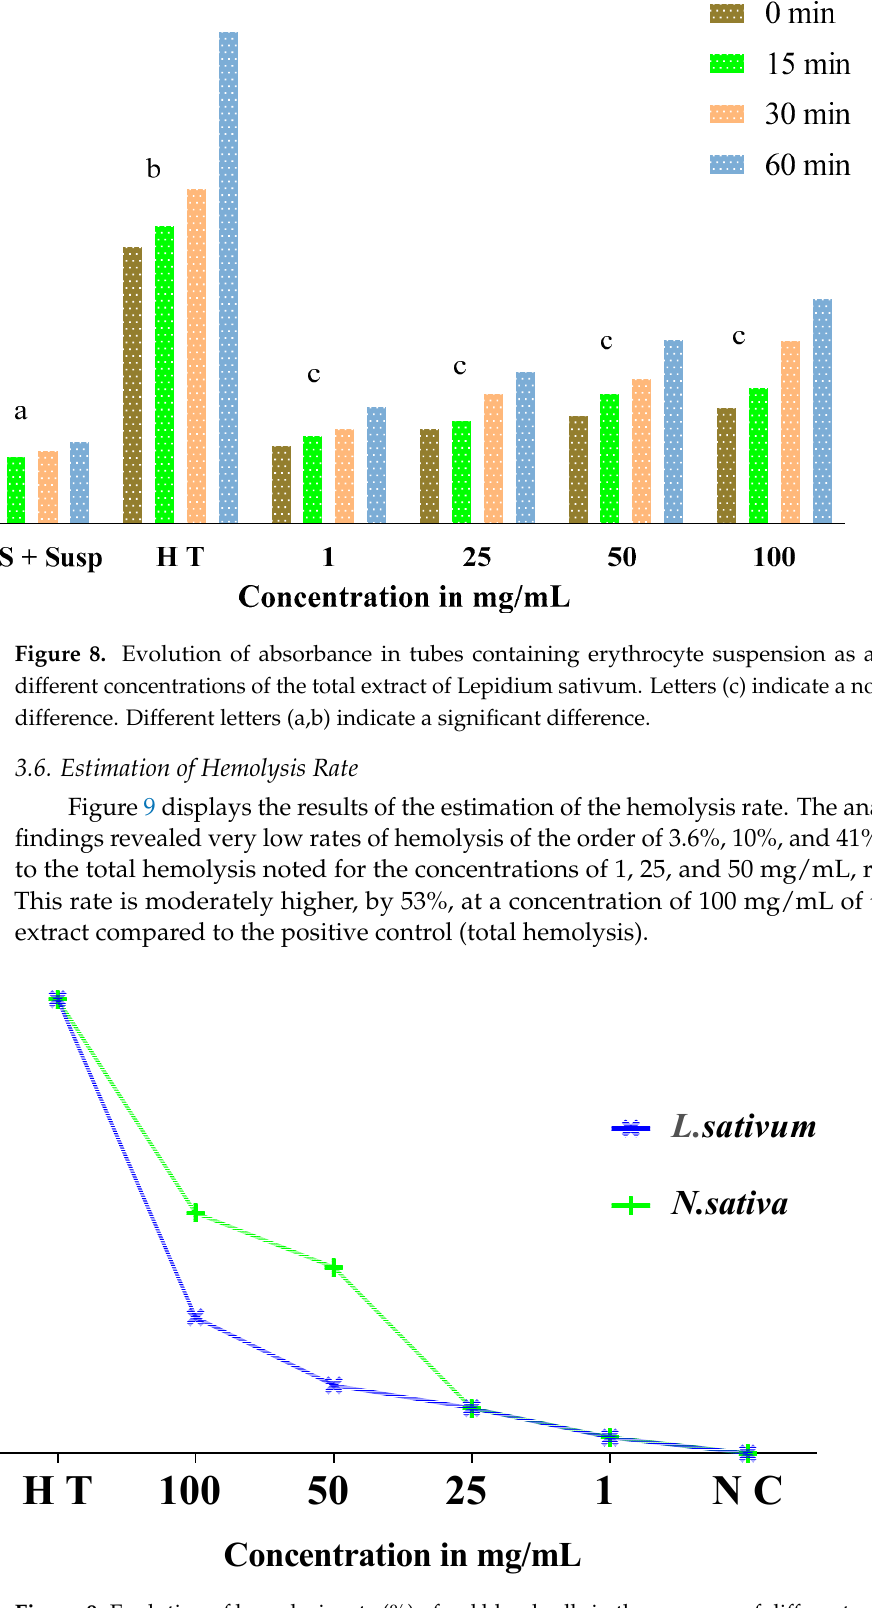
Figure 9. Evolution of hemolysis rate (%) of red blood cells in the presence of different concentrations of Nigella sativa and Lepidium sativum seed extract after 60 min incubation compared to total hemolysis (H T) and the negative control (T N).